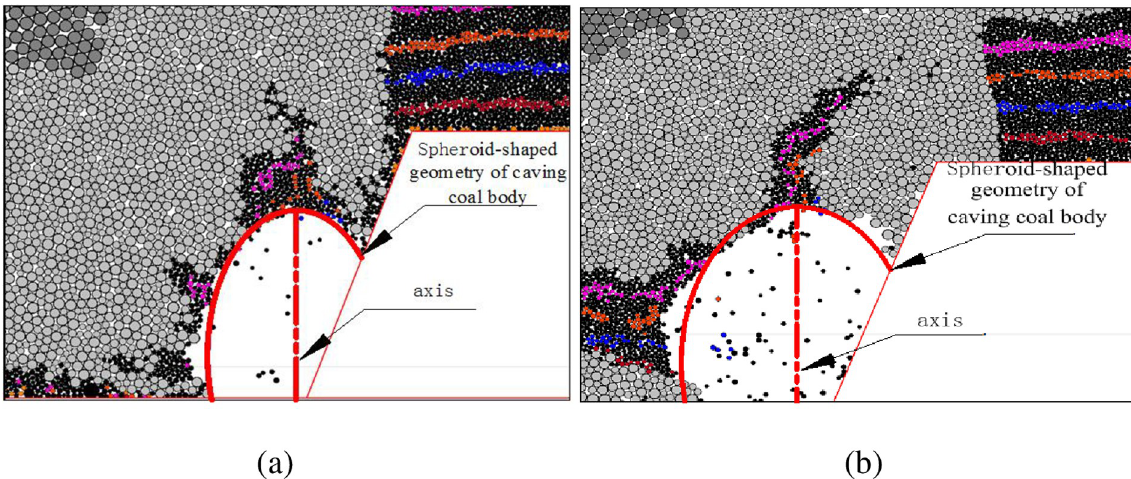
Fig 6. Geometry of recovered top coal: (a) below entries in upper seam; (b) below gob area in upper seam.